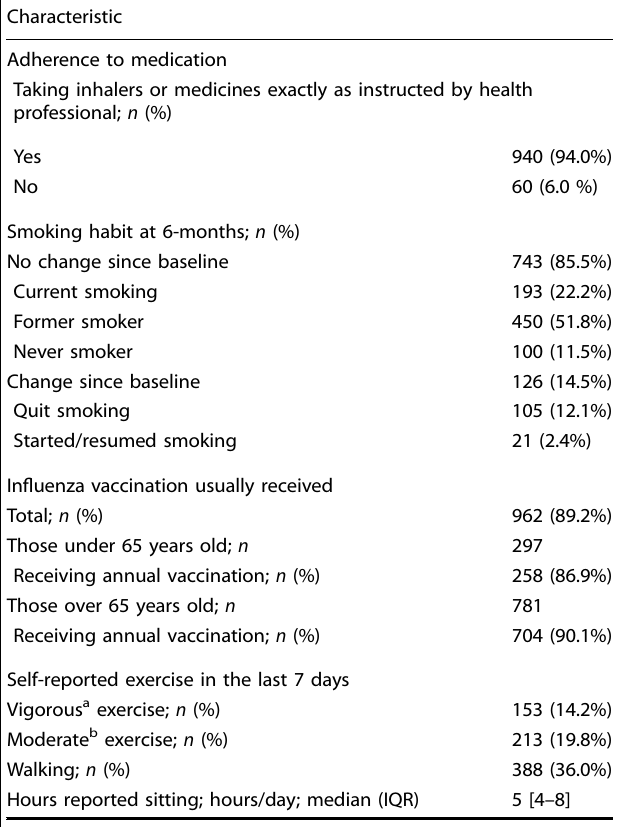
Table 2. Self-management behaviours: adherence to medication and